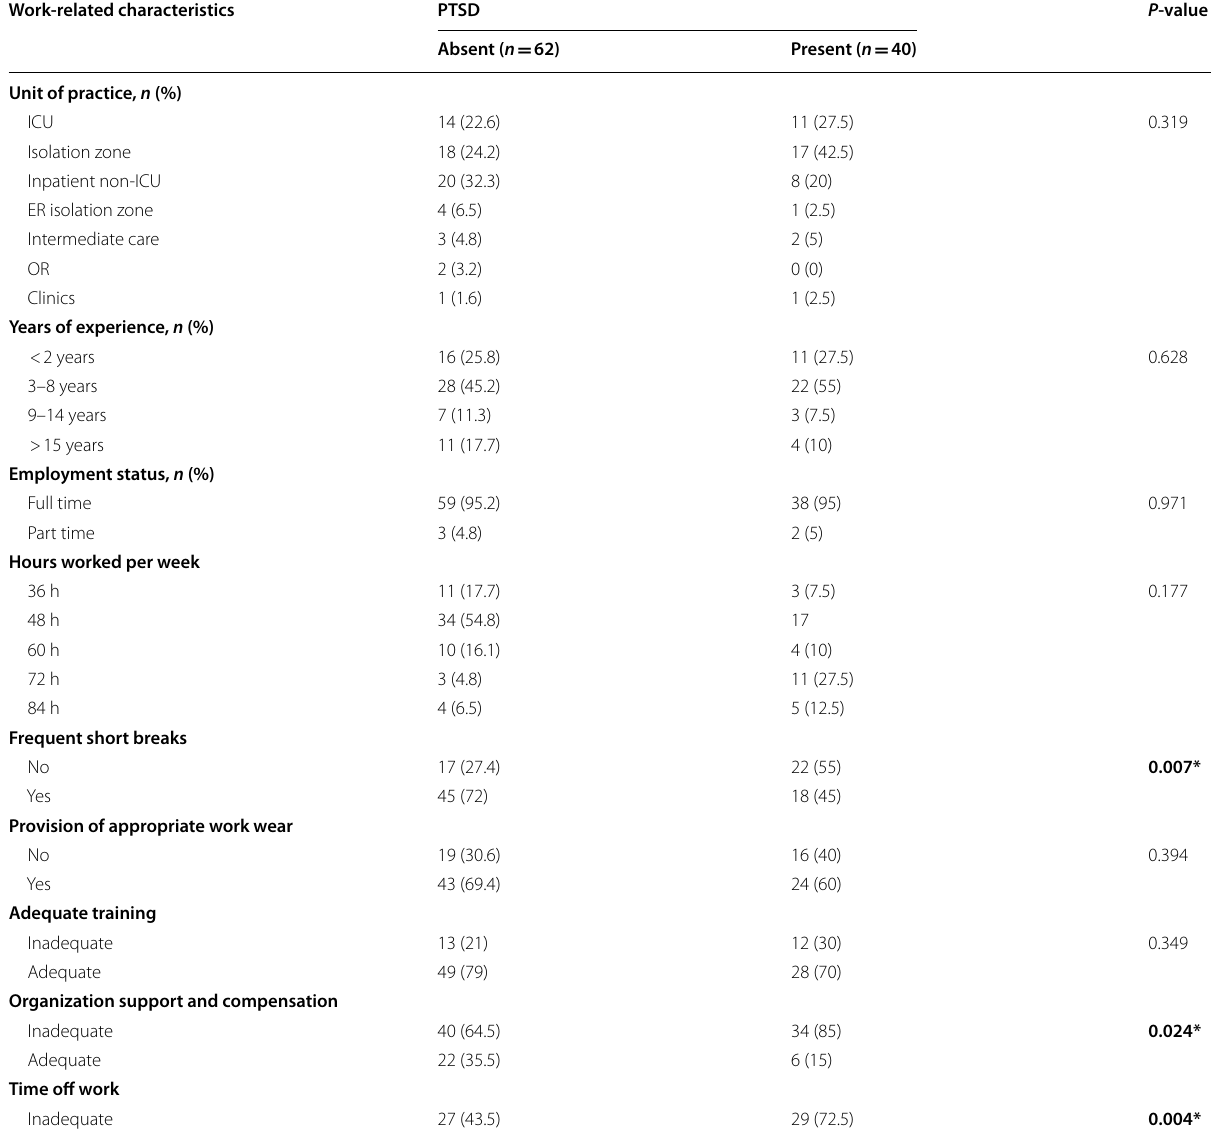
P -values are based on the chi-square test. Statistical significance at P